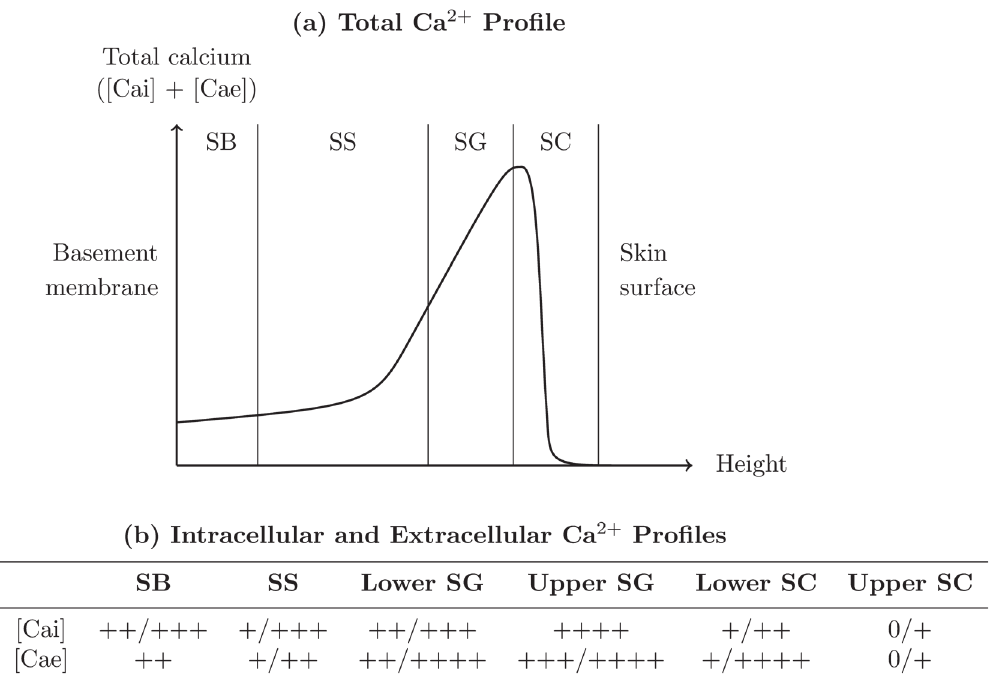
Figure 1. The epidermal calcium distribution. (a) Typical shape of the total profile found quantitatively using PIXE (for examples in the experimental literature, see [26, 28]). (b) Typical shape of the semi-quantitative intracellular ([Cai]) and extracellular ([Cae]) profiles measured using ion capture cytochemistry (for examples in the experimental literature, see [32 –